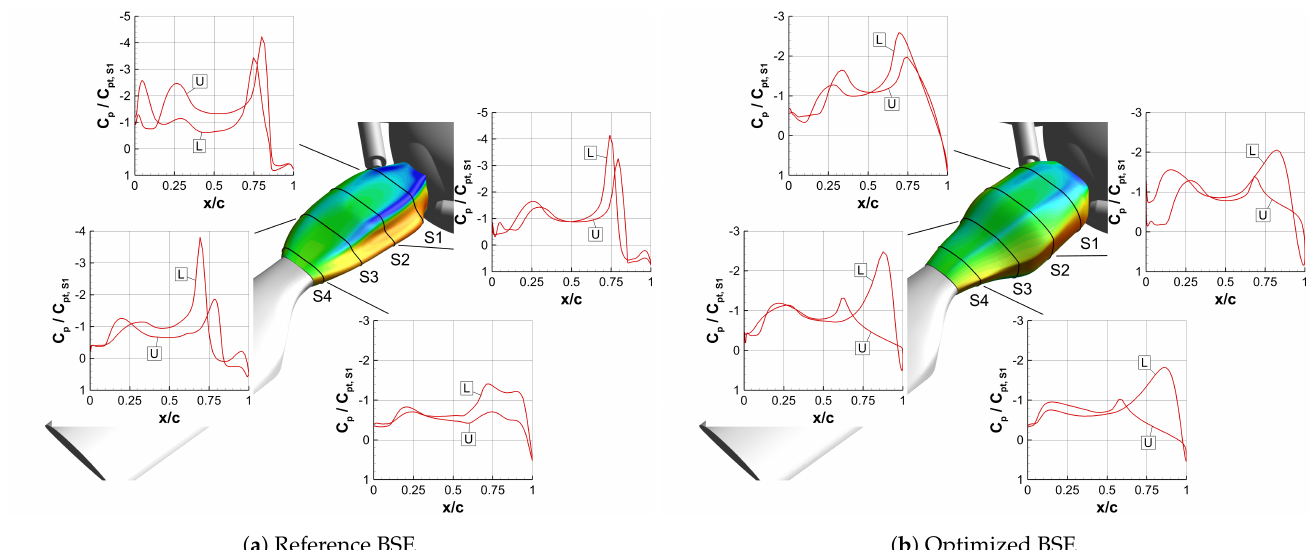
Figure 20. Comparison of the normalized, chord-wise surface pressure distribution C p / C pt , S 1 ( x / c ) at four radial sections S1-S4 considering the retreating rotor blade position ( Ψ = 270 ◦ ).